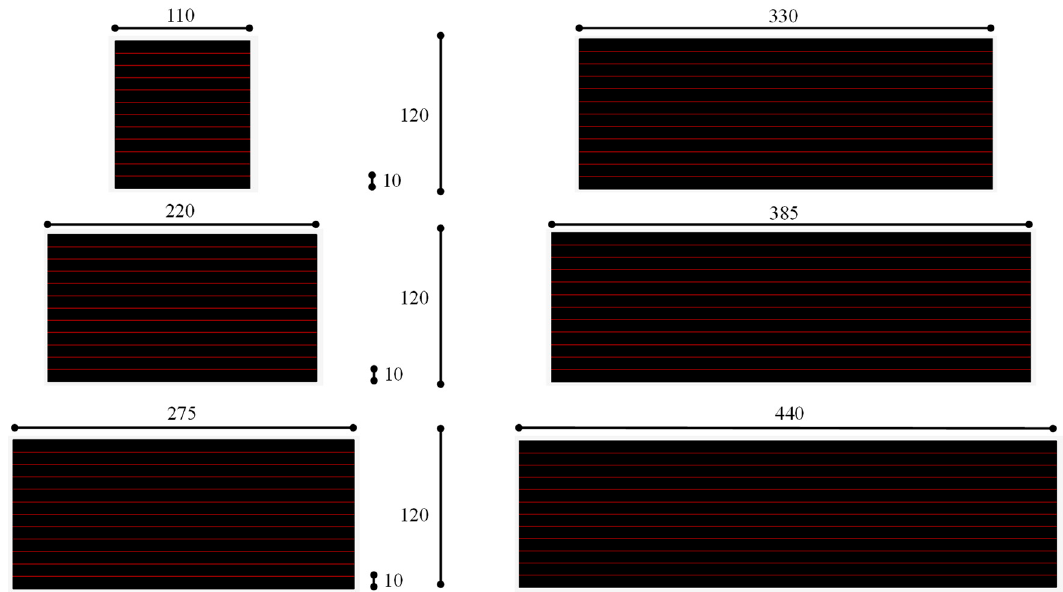
Figure 5. FEMs of the FREIs with different geometries (dimensions are in mm).